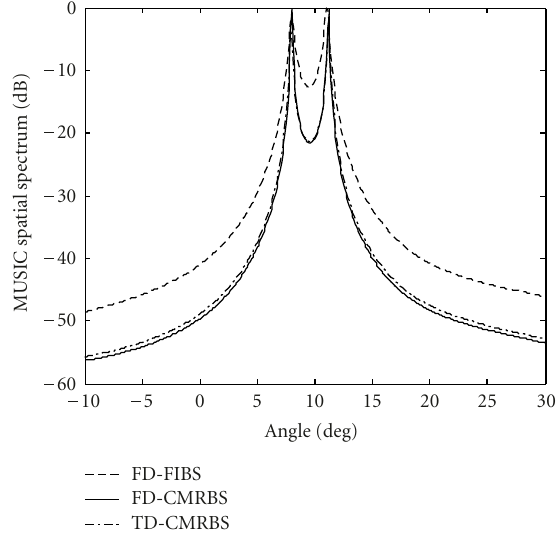
Figure 4: DOA estimation result for two correlated sources using FD-FIBS, FD-CMRDS, and TD-CMRDS.